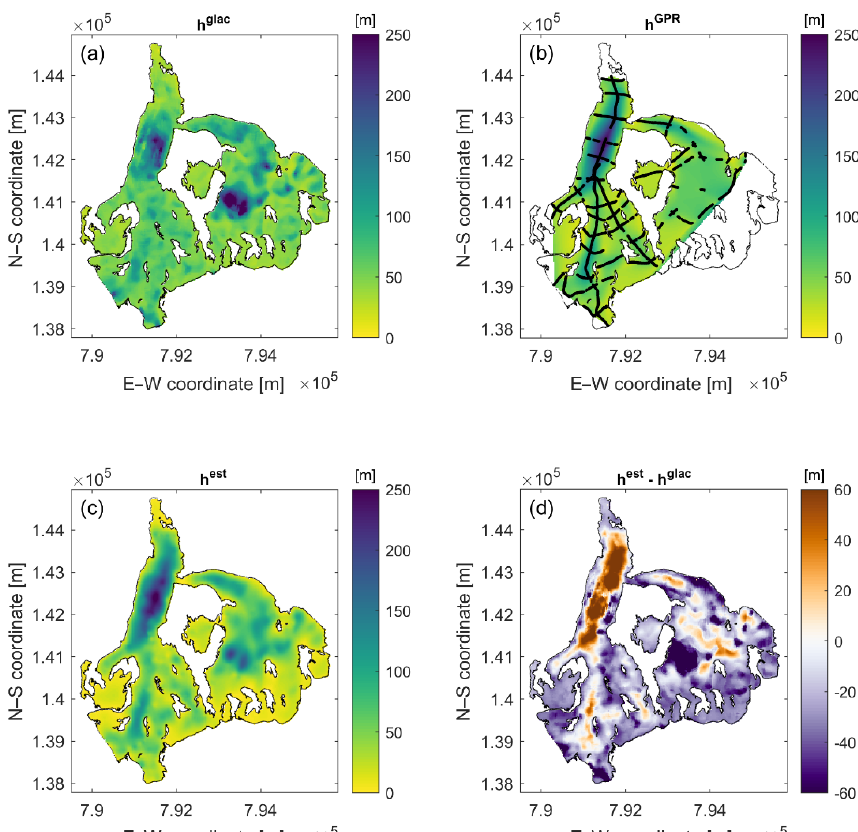
Figure 2. Results from Vadret da Morteratsch using only (a) glaciological constraints or (b) GPR constraints. Panel (c) shows the GlaTE inversion result, and panel (d) depicts the difference between the results shown in panels (a) and (c) . Colors indicate ice thickness or ice thickness differences. Available thickness data obtained from GPR profiles are marked with black lines in panel (b) .